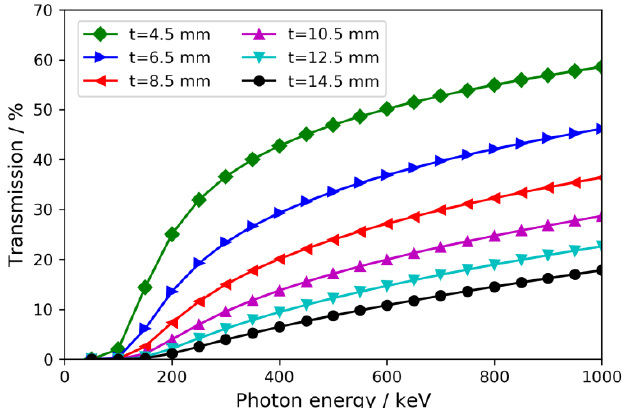
Figure 2. Calculated X-ray transmission of Inconel 718 for different values of the wall thickness t (i.e.,